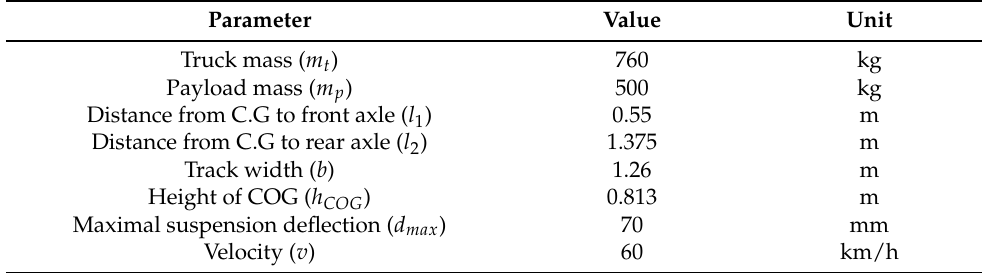
Table 3. Vehicle